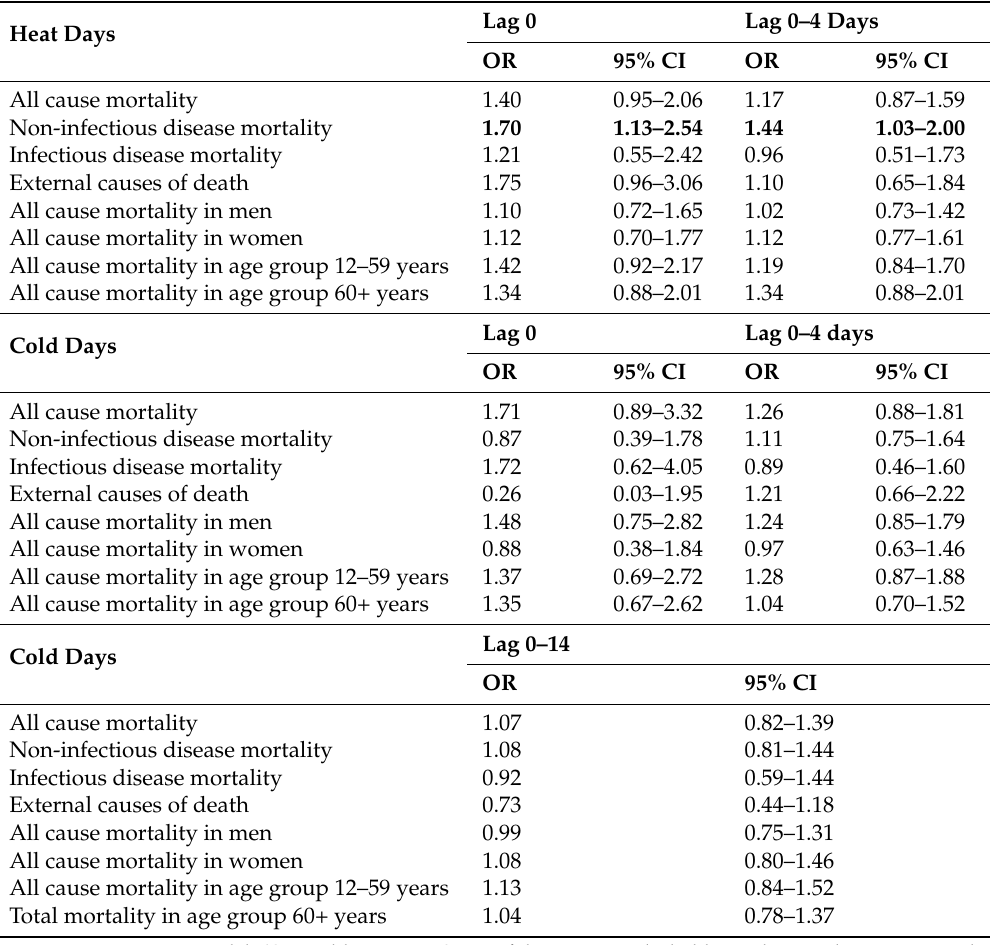
Table A1. Association of heat and cold with mortality stratified by cause, age, and sex Vadu HDSS, 2003–2012 (odds ratios with 95% confidence intervals).